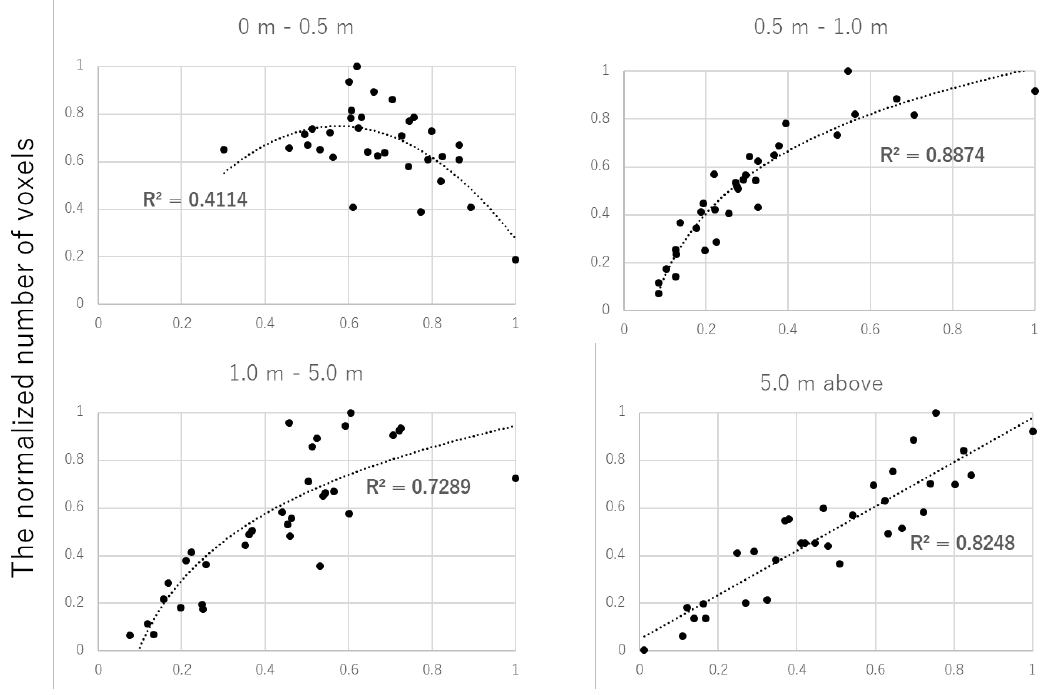
Figure 7. The relationship between the number of pixels in spherical coordinates ( x ) and the number of voxels in orthogonal coordinates ( y ) by different height strata (both axes are normalized by the maximum number and all R 2 values are statistically significant for the linear case and not-significant for the non-linear case with a significant level of 0.05).